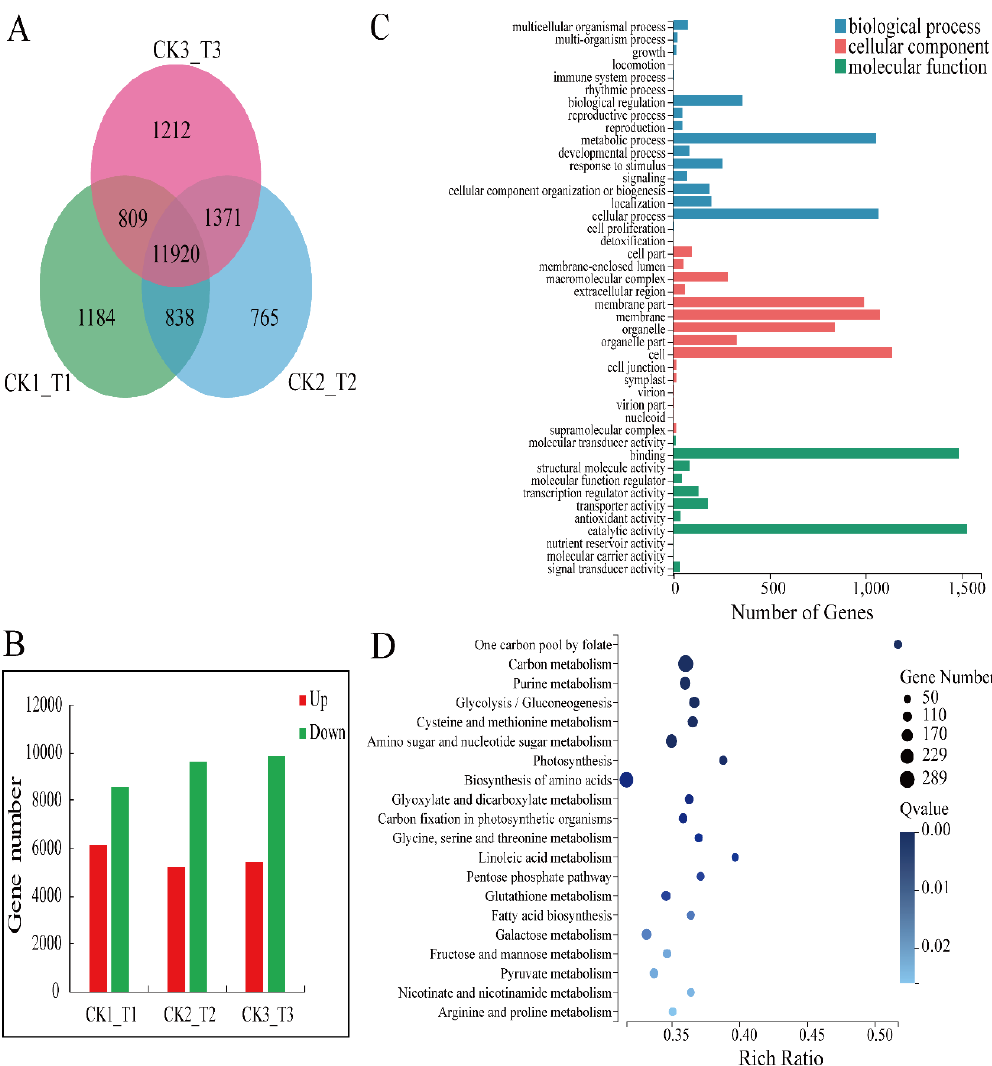
Figure 5. Analysis of differentially expressed genes (DEGs) of transgenic calli and CK. ( A ) Venn